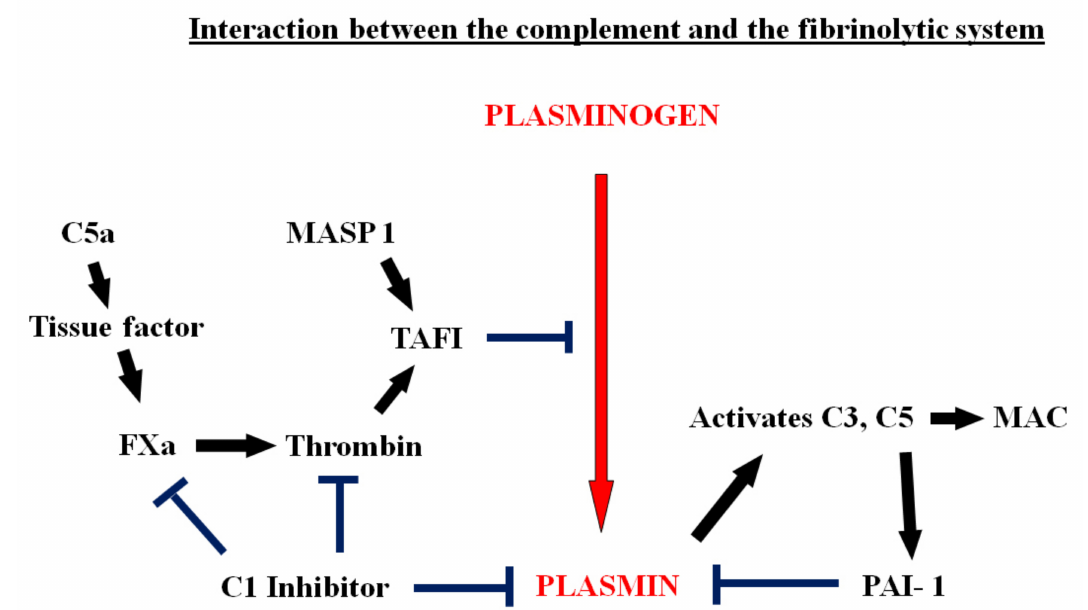
Figure 3. The interactions of the complement system with coagulation and fibrinolysis. C5a activates tissue factor, initiating the coagulation cascade, leading to thrombin generation and the formation of thrombin-activatable fibrinolysis inhibitor (TAFI). TAFI blocks the conversion of plasminogen to plasmin. TAFI can also be activated by another component of the complement system, MASP-1. C1 inhibitor blocks the activation of coagulation and inhibits plasmin. In addition, plasmin activates C3 and C5 directly and this leads to formation of the membrane attack (MAC). C5a also increases the expression of PAI-1 in mast